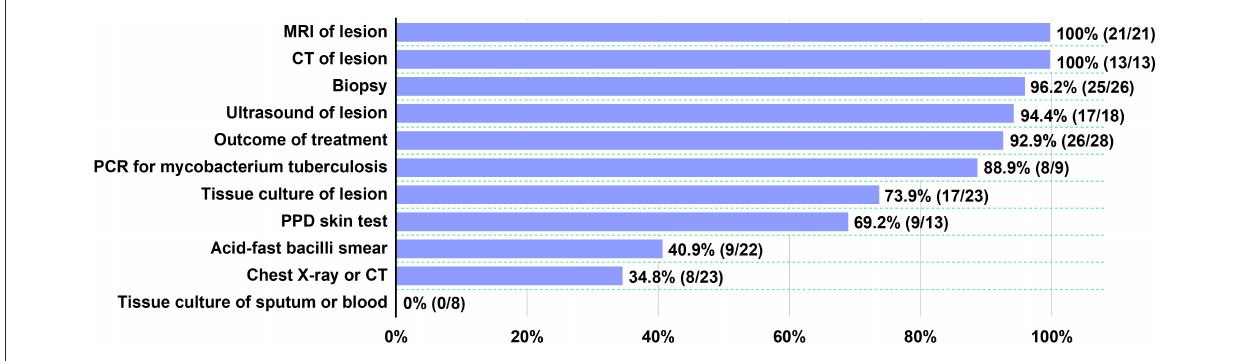
FIGURE2 Diagnostic tests for TB disease. For each test, the proportion of positive patients is